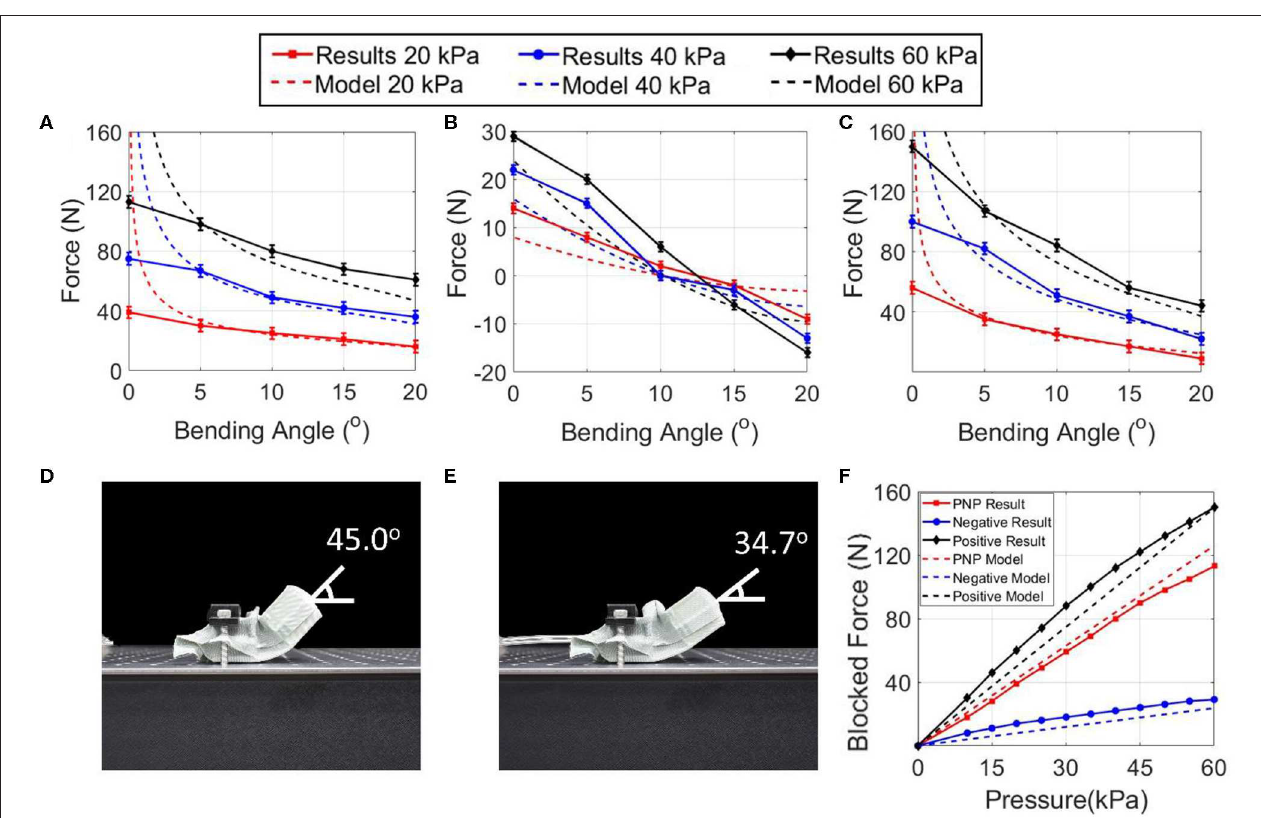
FIGURE 3 | Bending force vs. bending angle at different pressures for (A) negative pressure actuation, (B) positive pressure actuation, and (C) PNP actuation. Equilibrium angle of the actuator with a single segment using (D) negative pressure actuation, and (E) PNP actuation. (F) Blocked force of the actuator vs.